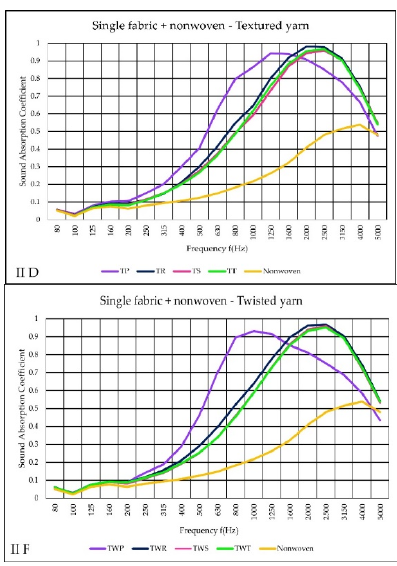
Figure 6. Sound absorption coefficient ( α ) versus frequencies f (Hz) results of II variant ( D – F ) single woven fabric + nonwoven.